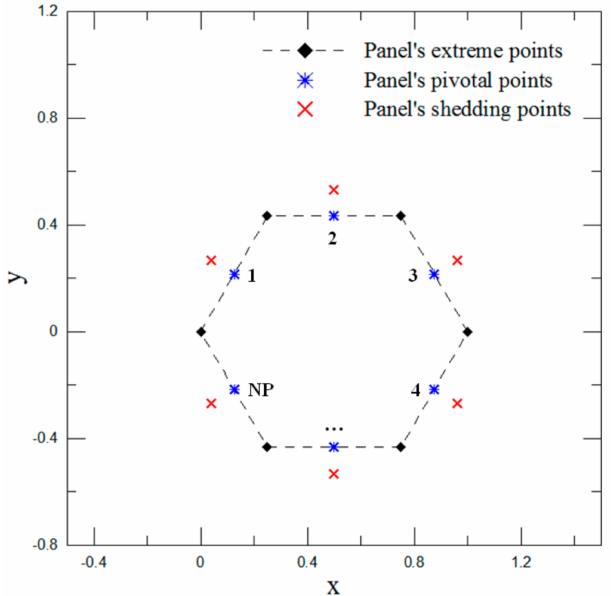
Figure 2. Circular cylinder surface discretized by NP flat panels (in this example, NP =